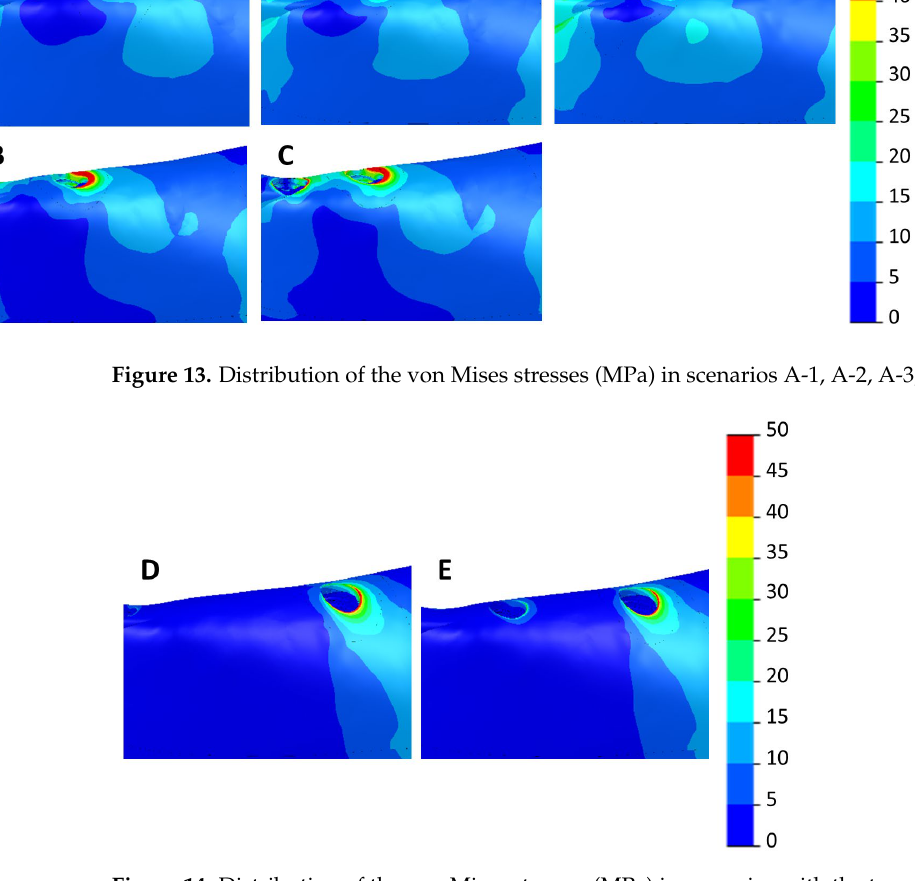
Figure 14. Distribution of the von Mises stresses (MPa) in scenarios with the two posterior im- plants distally to the foramina. Left—4 implants (D). Right—6 implants (E).